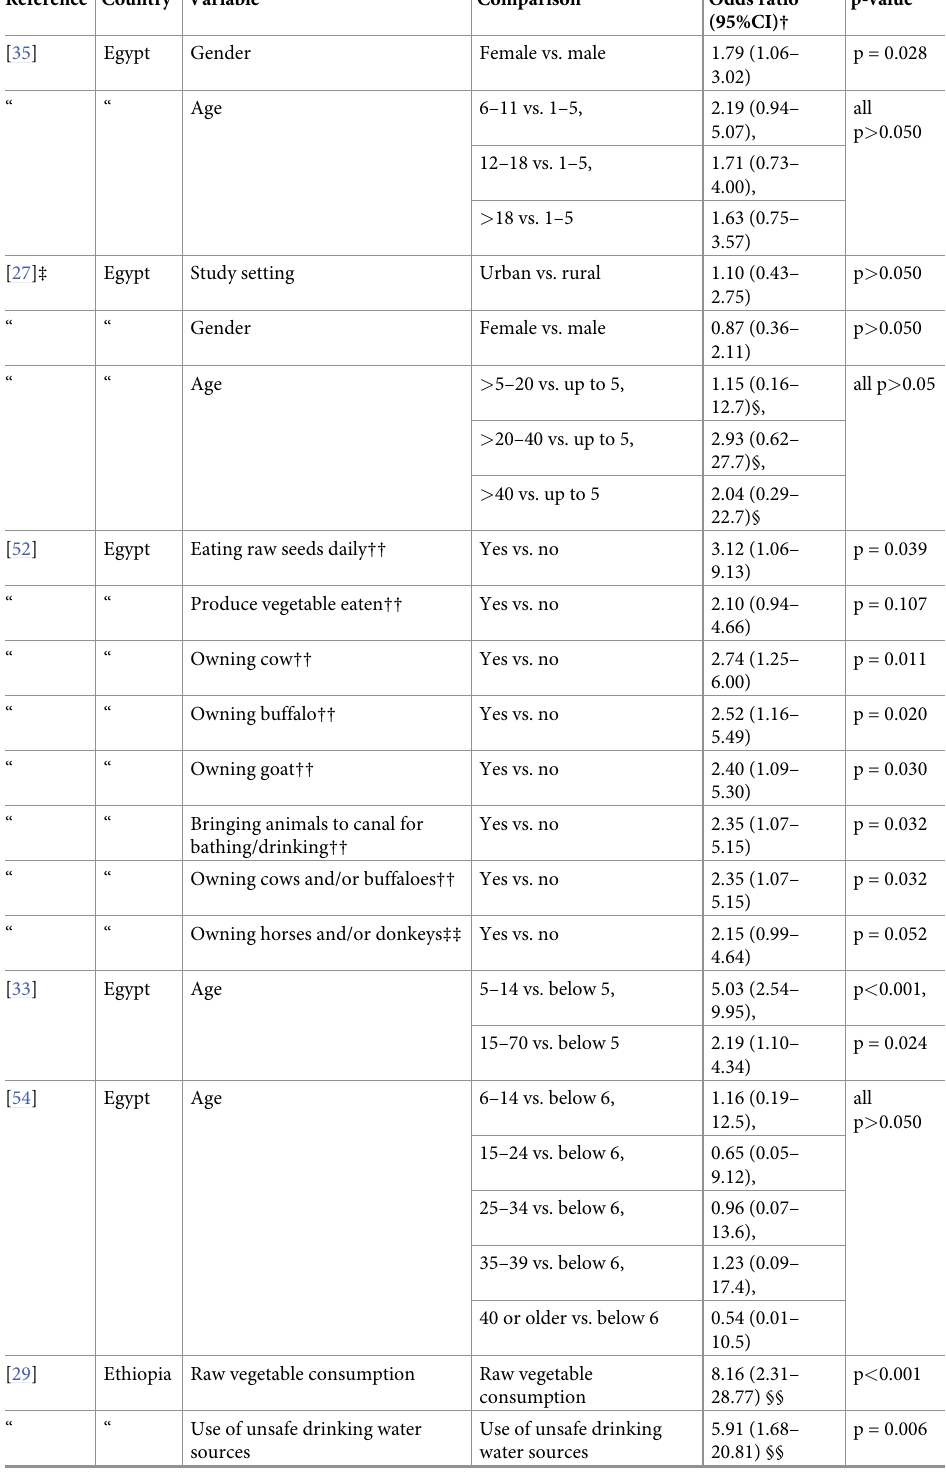
Table 2. Epidemiological factors investigated in population screening studies retrieved in a systematic review on human fascioliasis in